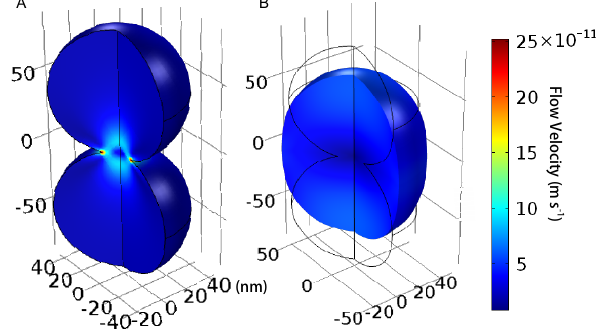
Figure 5. Flow simulation for the transformation of a dimer ag- glomerate into a spherical particle. (a) shows the initialization for t = 0s. Two monomers having a diameter of 45nm and overlapping by 5nm are shown. The coloring represents the instantaneous flow velocity. (b) shows the end of the simulation at t = 310s. The full time series is shown in film clip S1. The viscosity and its standard deviation, ( 1 . 0 ± 0 . 2 ) × 10 8 Pas, were optimized in the simulation so that the transformation from a dimer in (a) to a sphere in (b) was complete after 310s (cf. data of Fig. 4b and see also main text). In (b) , the black lines represent the original shape of the particle (i.e., a